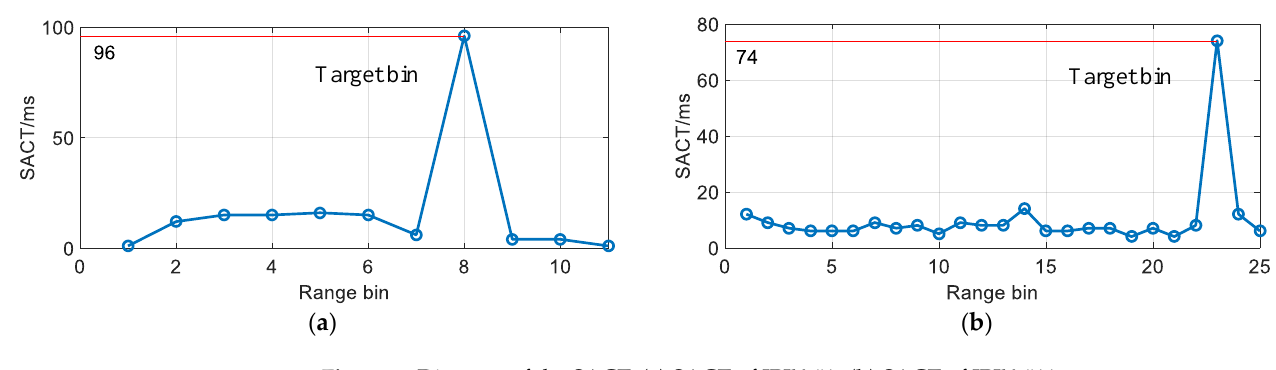
where y i ( n ) denotes the time sequence of the adjacent bin and m denotes the number of the adjacent bin. Similarly, the WCCT is also defined as: where τ 2 is the time when the cross-correlation coefficient r j drops from 1 to 0.5. The WCCT of IPIX-#1 and IPIX-#11 are shown in Figure 4. The results confirm that the target echoes and sea clutter differ in WCCT and the target echoes have weaker cross-correlation compared to the sea clutter.